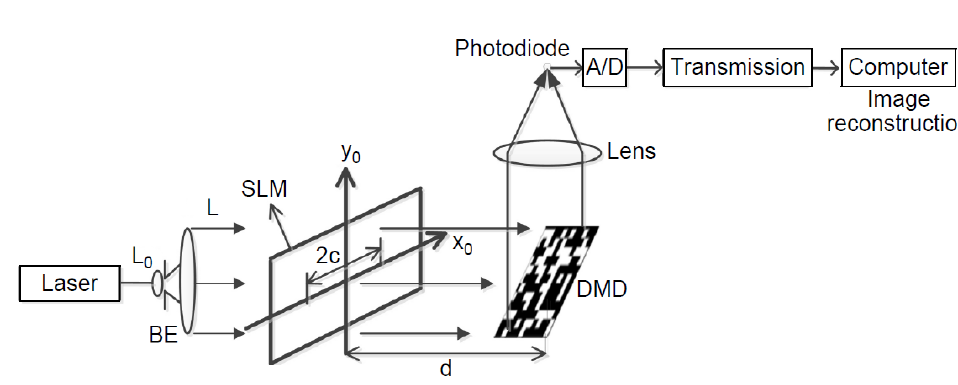
Figure 7. Proposed setup of a system of encryption of compressed images using PST and a JTC. Here, L: light; BE: beam expander; SLM: spatial light modulator; DMD: digital micro-mirror device